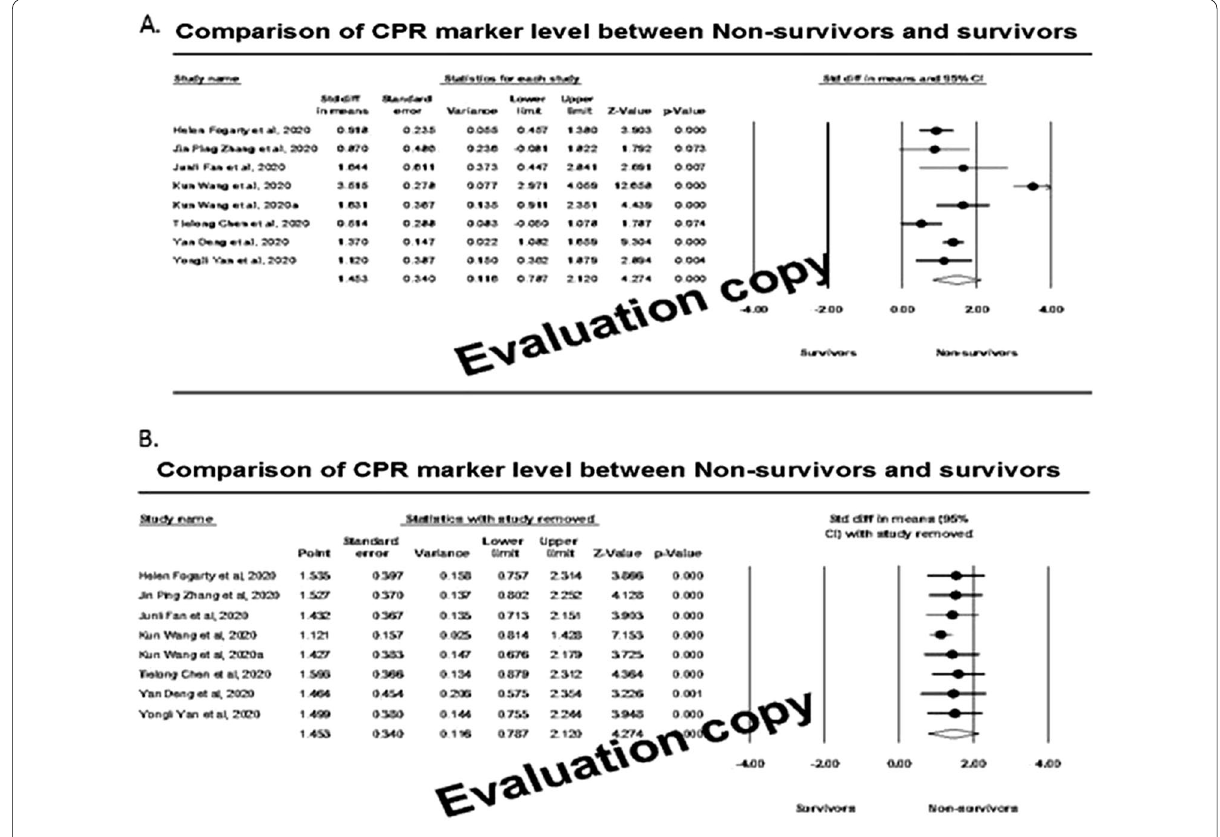
Fig. 2 Forest plot ( A ) and sensitivity analysis ( B ) of effect size among survivors and